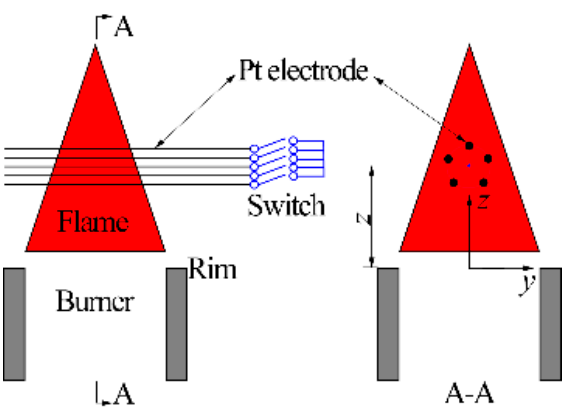
Figure 3. Schematic of the electrode structure for experiments of Factor 1. Table 3. Experimental conditions for Factor 1.